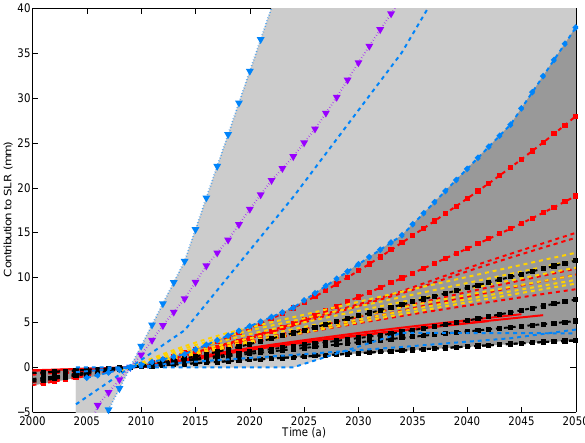
Figure 4. Evolution of the cumulated contribution of Pine Island Glacier to SLR until 2050 as computed by models participating in SeaRISE experiment M3 (blue lines), SISM for the SeaRISE M3 forcing (purple line), together with estimations from Joughin et al. (2010) (black lines), Favier et al. (2014) (red lines) and Seroussi et al. (2014) (orange lines) for the same region. Models are or- dered according to their complexity: SIA (dotted lines with trian- gles), SSA (dashed lines with squares), heuristic approach (dashed lines with circles), L1Lx (dashed line) and full-Stokes (continuous). Starting time of SeaRISE experiments is 2004 (Bindschadler et al., 2013). Starting times of experiments computed by Joughin et al. (2010) and Seroussi et al. (2014) correspond to the acquisition year of the surface velocities used for inversion, 1996 and 2008, respec- tively. As detailed in Favier et al. (2014), the starting time of their experiments corresponds to the last grounding line measurements available, i.e., completed in 2011 (Park et al., 2013). Cumulated contribution was offset to zero in 2009. The light gray (dark gray) envelope encompasses the SeaRISE ensemble (MISMIP-verified ensemble,